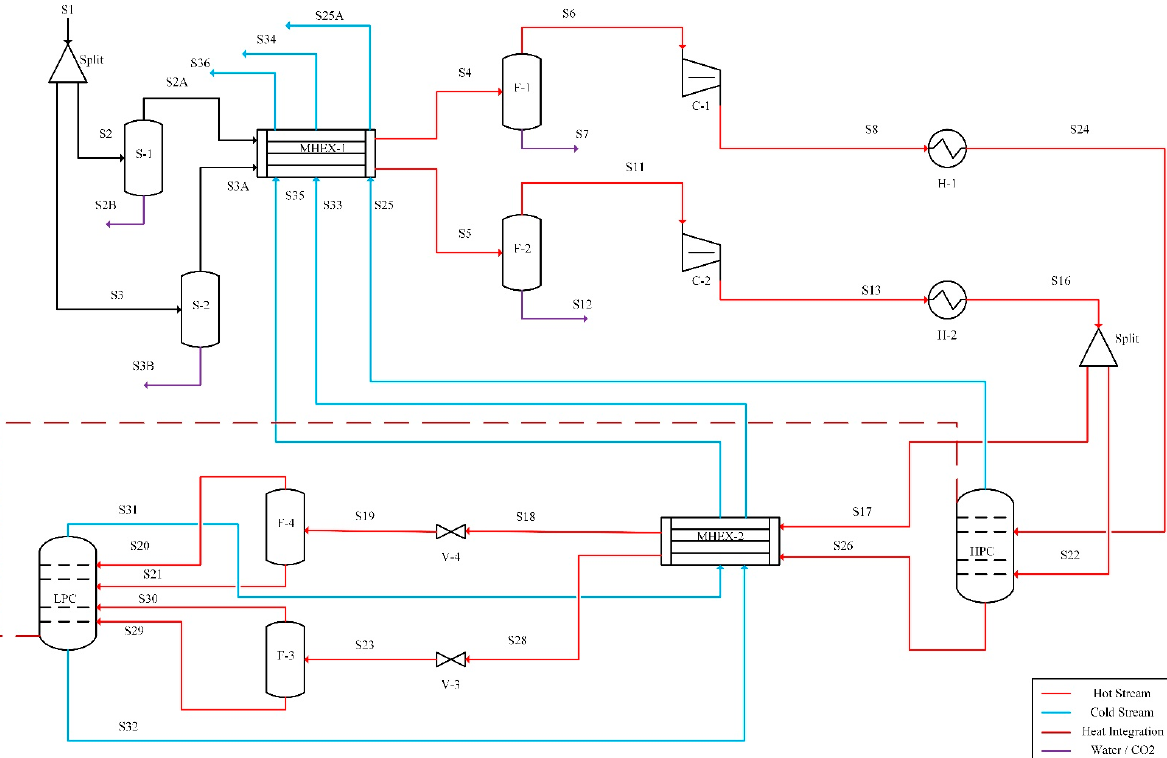
Figure 1. Process flow diagram of the revised ASU configuration C7r.